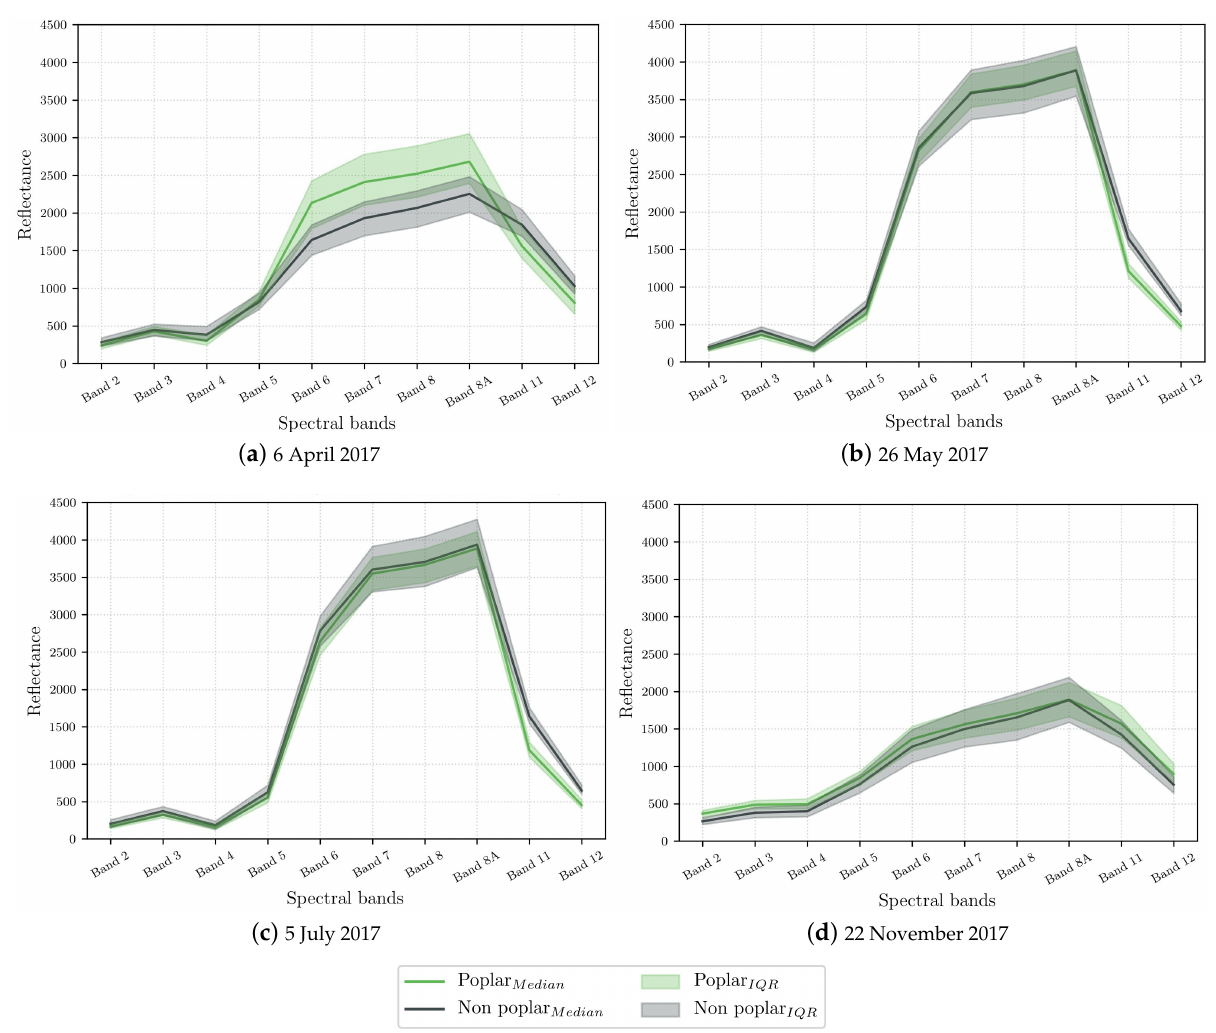
Figure 3. Spectral reflectance (multiplied by a factor of 10,000) of poplar plantations versus deciduous tree species on four different dates in 2017. The solid lines represent the median signal, and the surrounding shaded areas represent the interquartile range, in green for poplar and in grey for the other deciduous